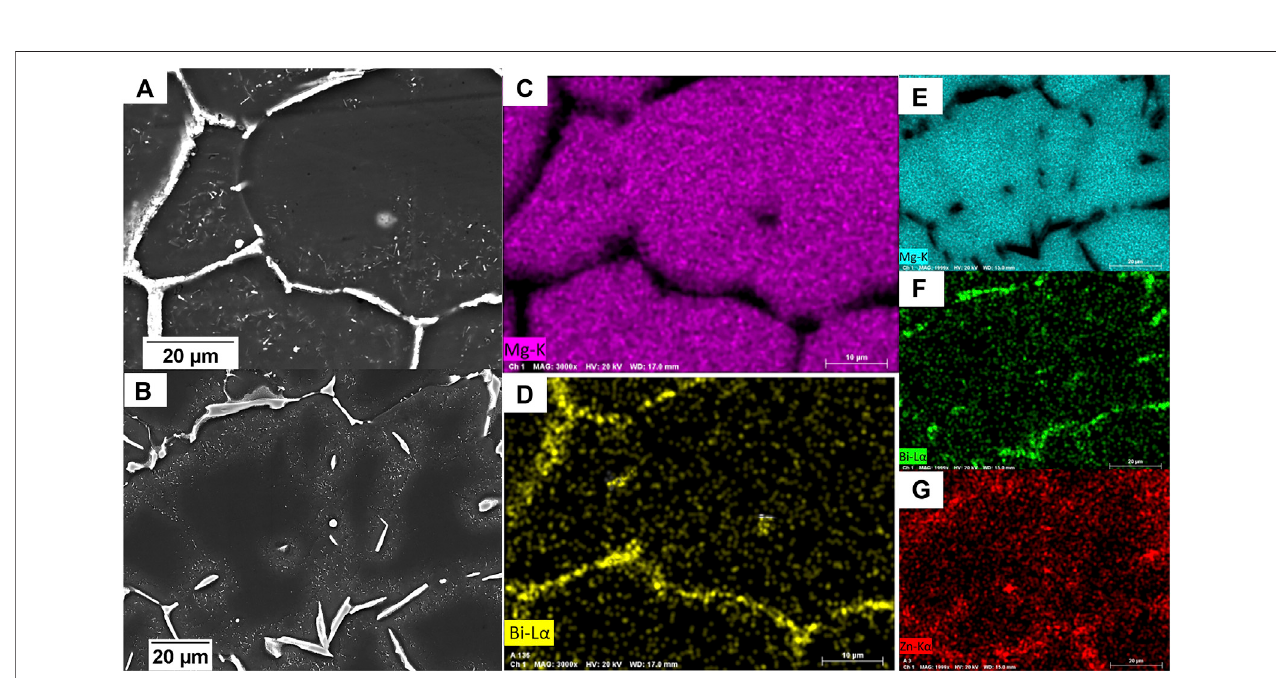
FIGURE 2 | EDX analysis of (A) (C) (D) Mg-9Bi alloy and (B) (E) (F) (G) Mg-9Bi-2.5Zn.